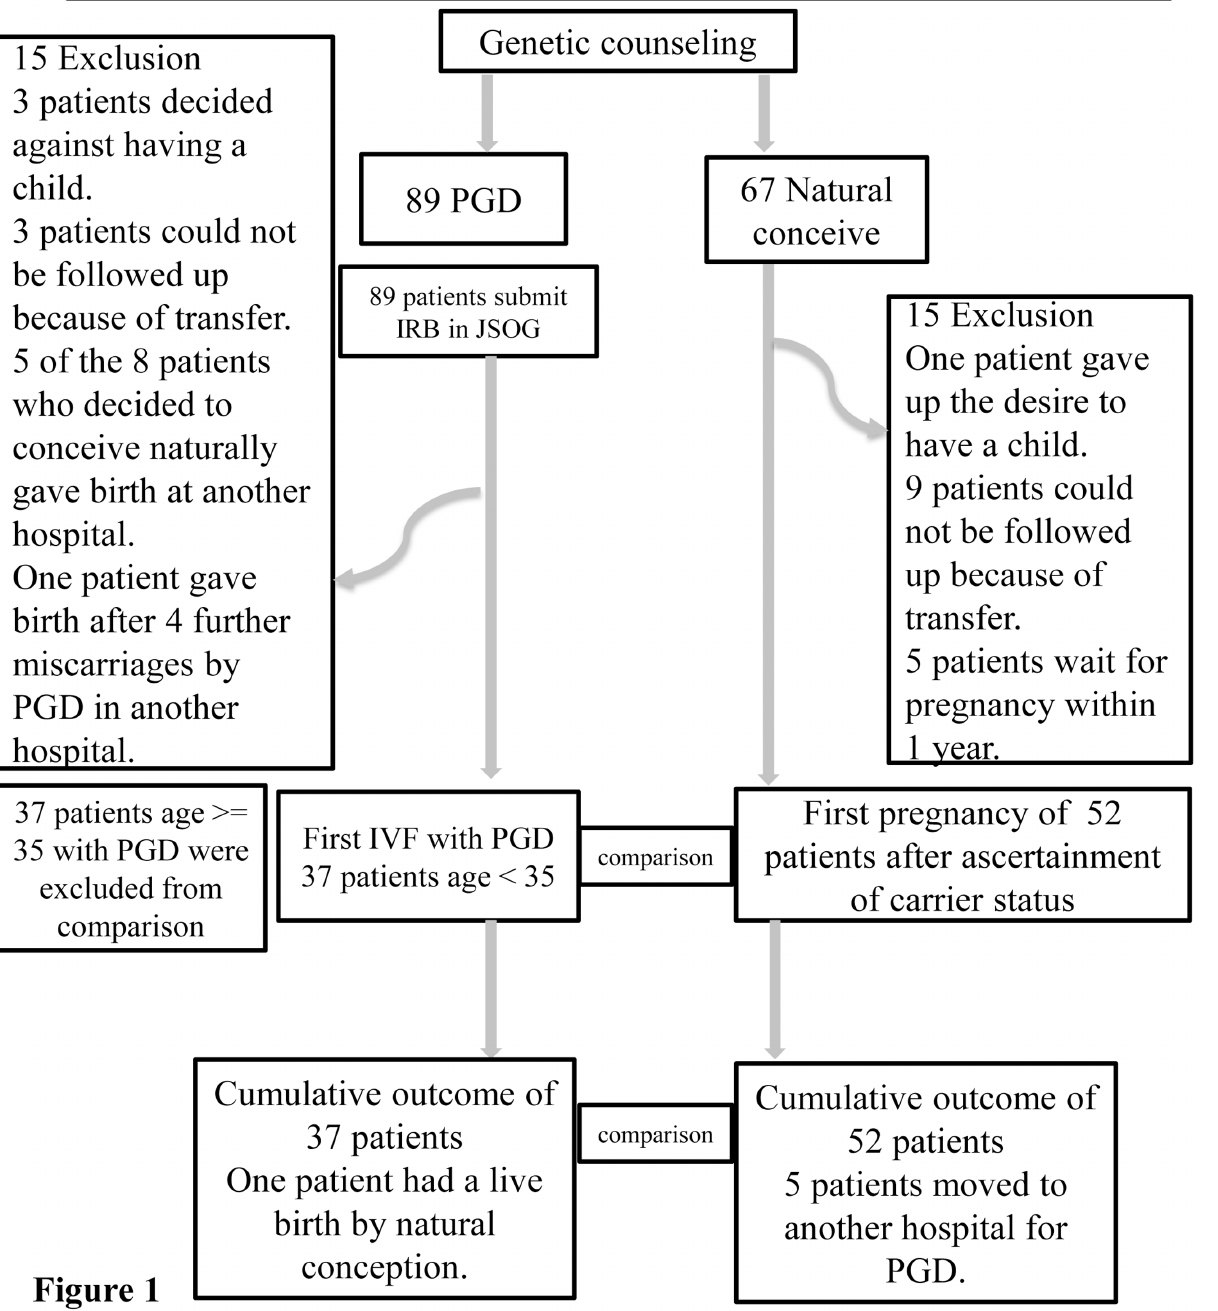
Fig 1. Of 156 patients with reciprocal or Robertsonian translocations who received genetic counseling, 67 chose natural conception and 15 were excluded from the study. The remaining 89 chose PGD and 15 were excluded from the study. All comparisons were performed between the 37 patients of the PGD group who were (cid:1) 34 years old and the 52 patients who conceived naturally so that the patients who underwent PGD could be matched for age. The subsequent outcomes of the 126 patients were ascertained from the medical records and by telephone until July 2014.